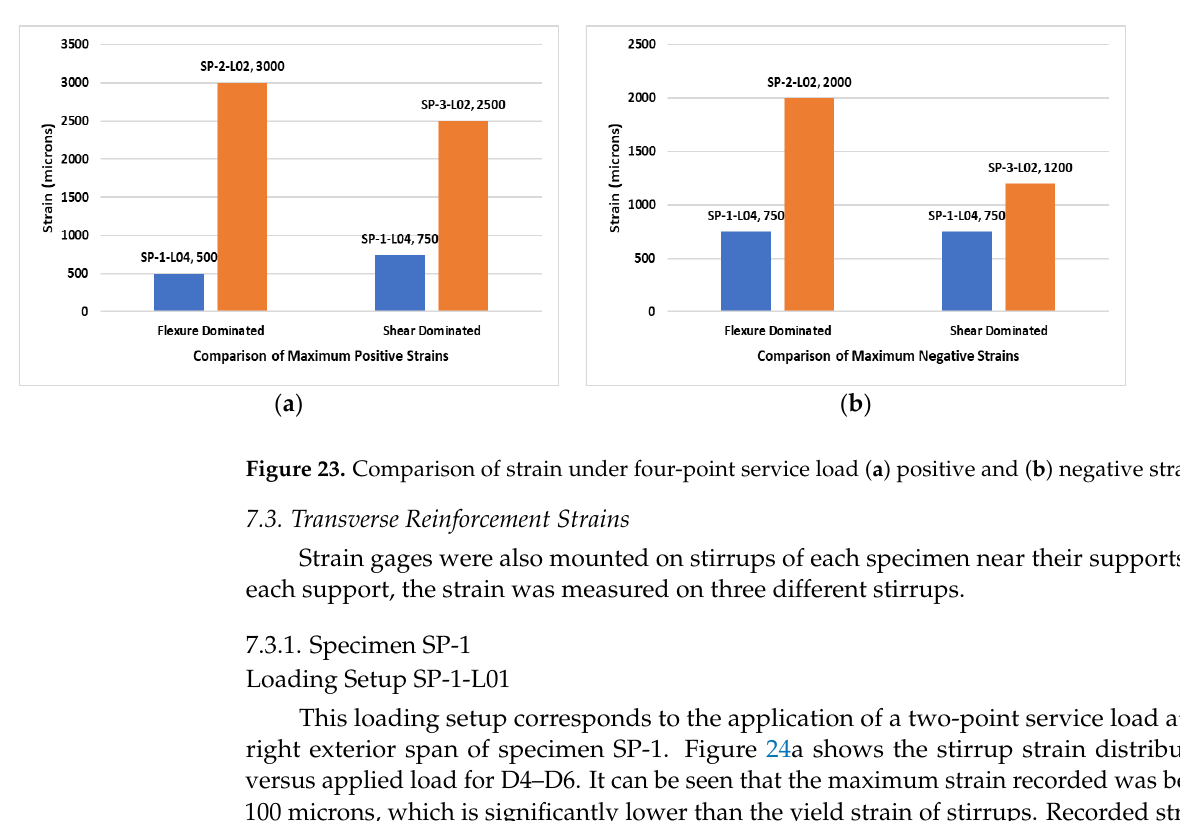
Figure 23. Comparison of strain under four-point service load ( a ) positive and ( b ) negative strain. Comparison between SP-1-L04 and SP-3-L02